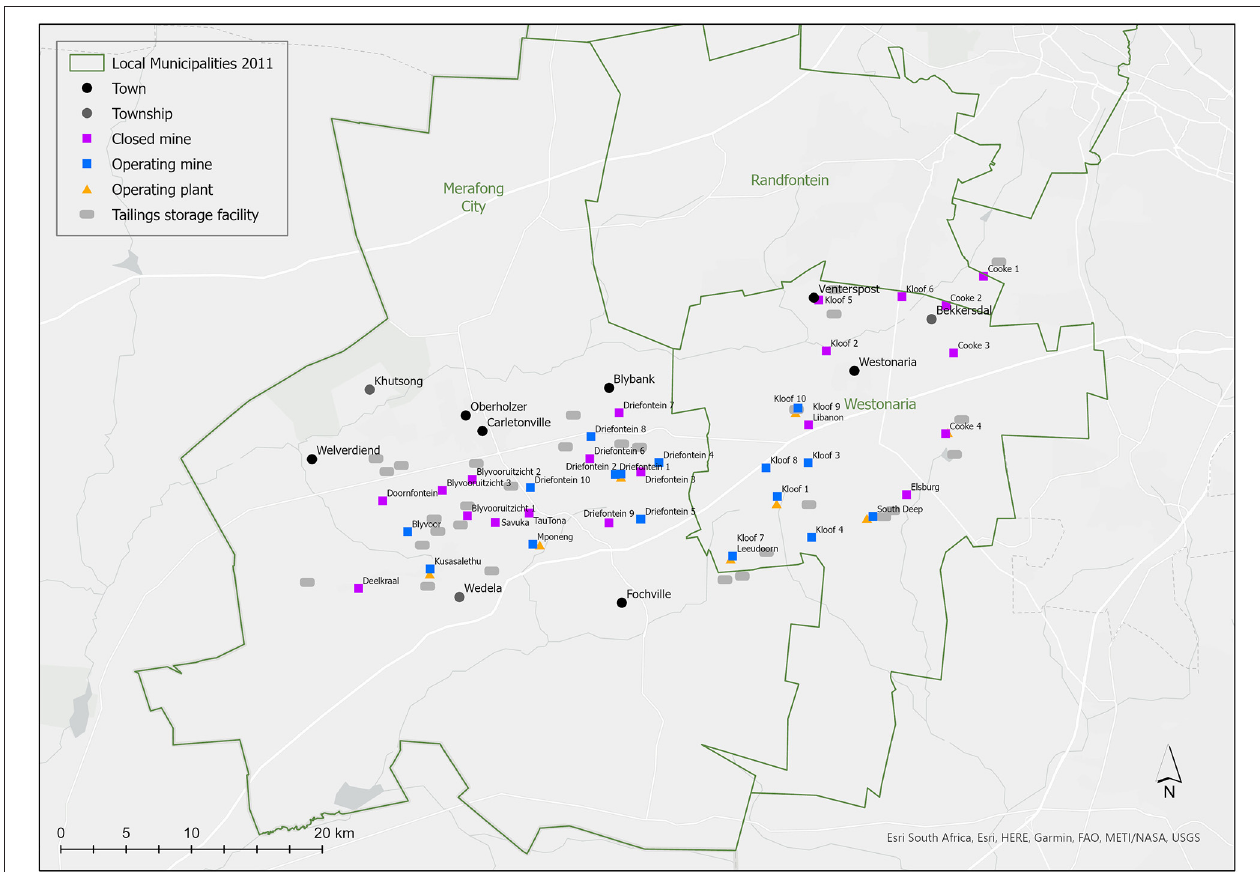
FIGURE 1 | Map of the communities, mines, operational processing plants and tailings storage facilities in the West Wits goldfield.